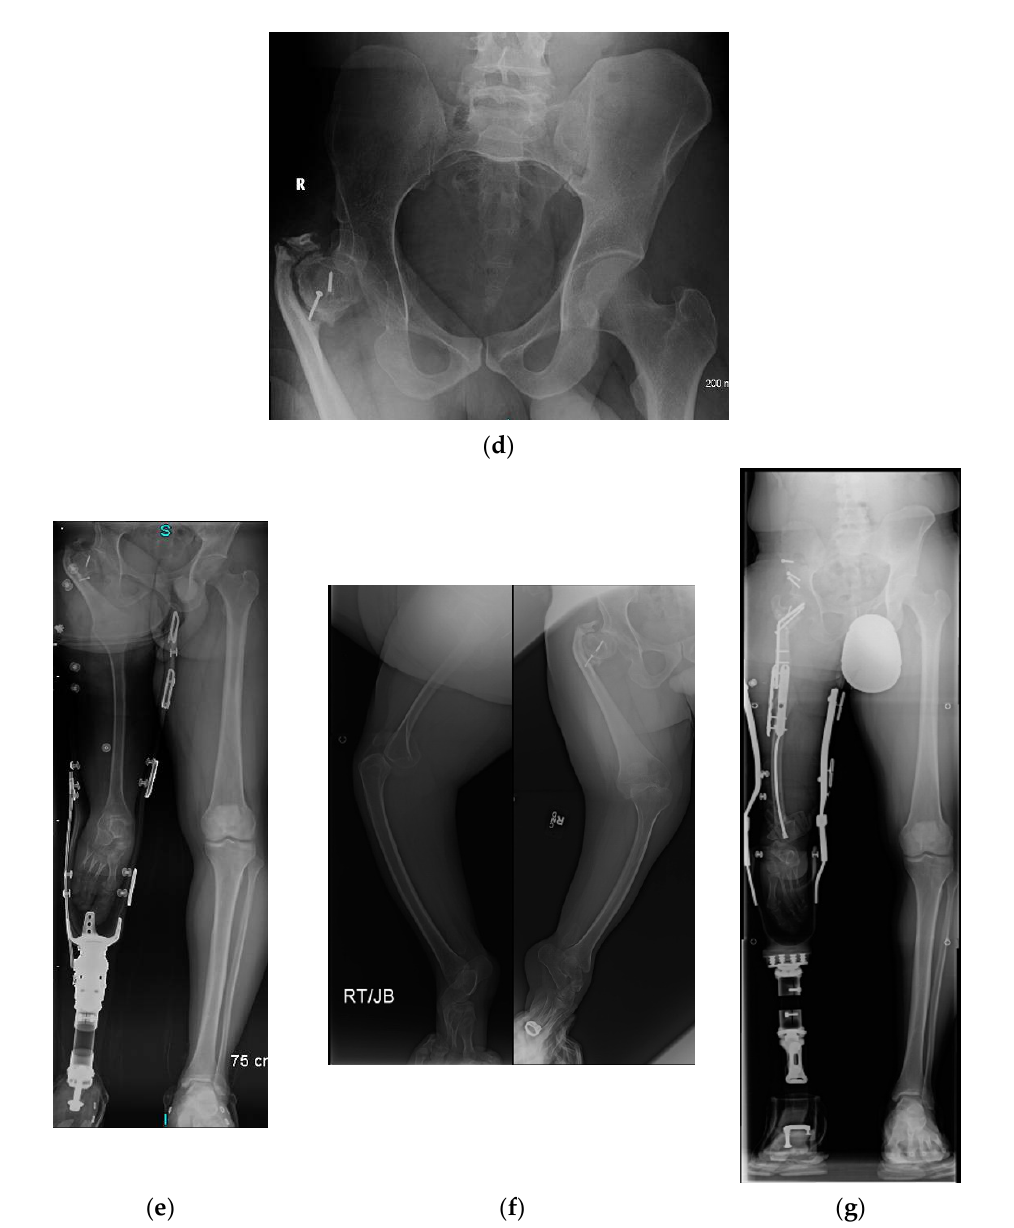
Figure 6. ( a ) Illustration of CFD type 1a3 or 1b. ( b ) Illustration showing the first step which is SUPERhip procedure with resection of knee joint. ( c ) Illustration showing the second step which is PaleySUPERhip–Van Nes rotationplasty at level of the knee fusion. ( d ) AP pelvis on 36-year-old man with CFD type 1b with prior failed hip surgery. ( e ) Standing radiograph in same man showing ankle at level of opposite knee joint. ( f ) Long lateral and AP radiographs showing the knee joint in the same patient was unstable, deformed and subluxated. ( g ) Standing radiograph one year after PaleySUPERhip–Van Nes procedure including SUPERhip, knee fusion and supramalleolar osteotomy, wearing rotationplasty prosthetic. Ankle is at level of opposite knee. This procedure greatly improved his quality and of life, gait and